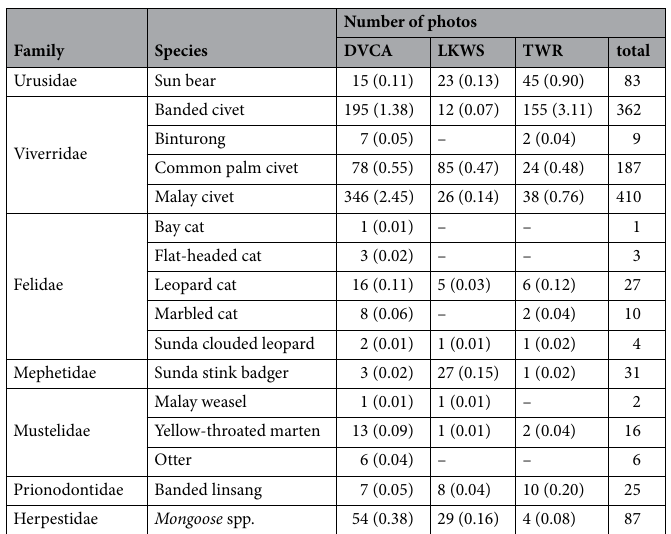
Table 1. The number of independent photo-capture of carnivore species in the three study sites. Numbers in parenthesis indicate the photo-capture frequency (number of independent events/100 camera-trap